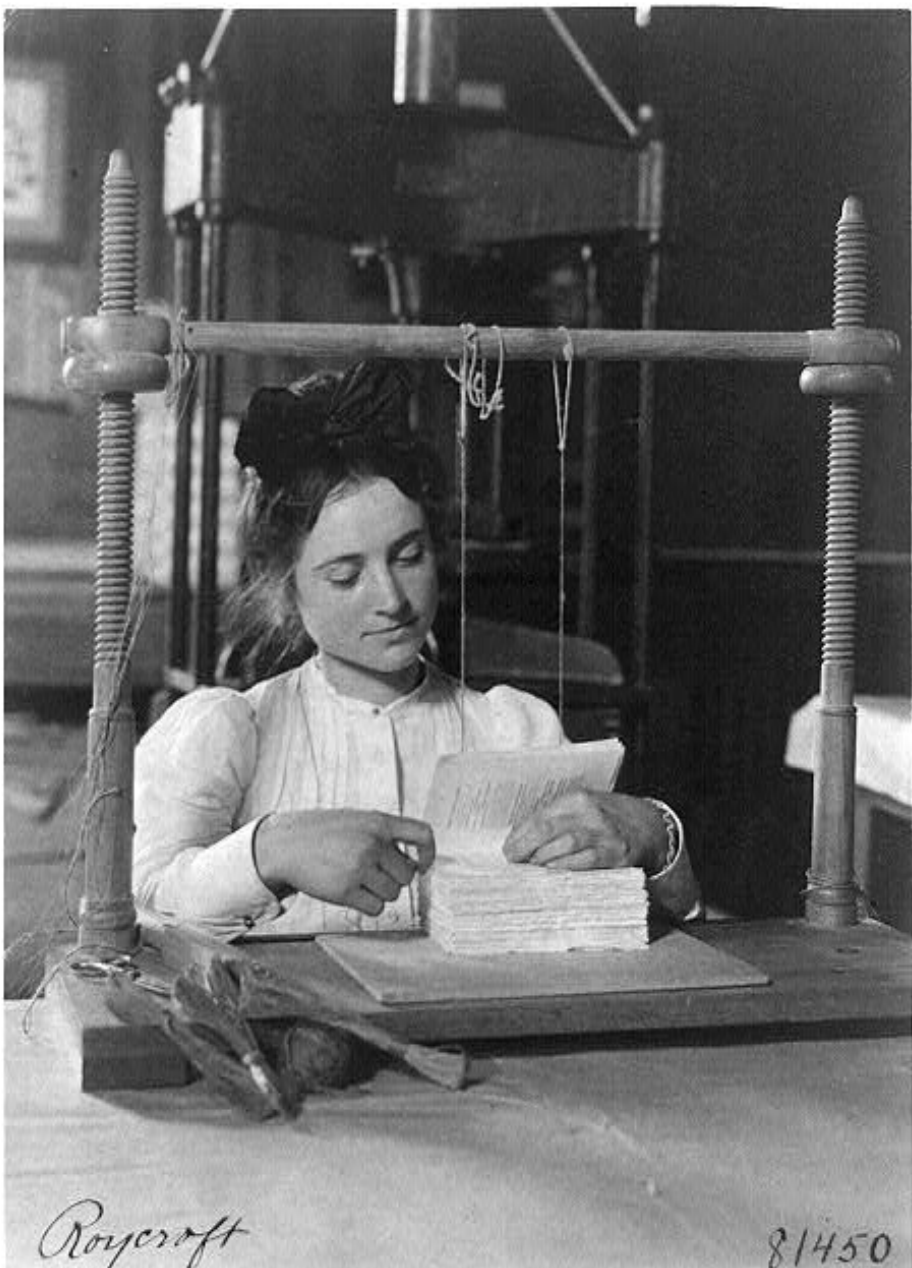
Figure 26. Frances Benjamin Johnston 1895. Woman Doing Bookbinding at Roycroft Shop. Library of Congress.